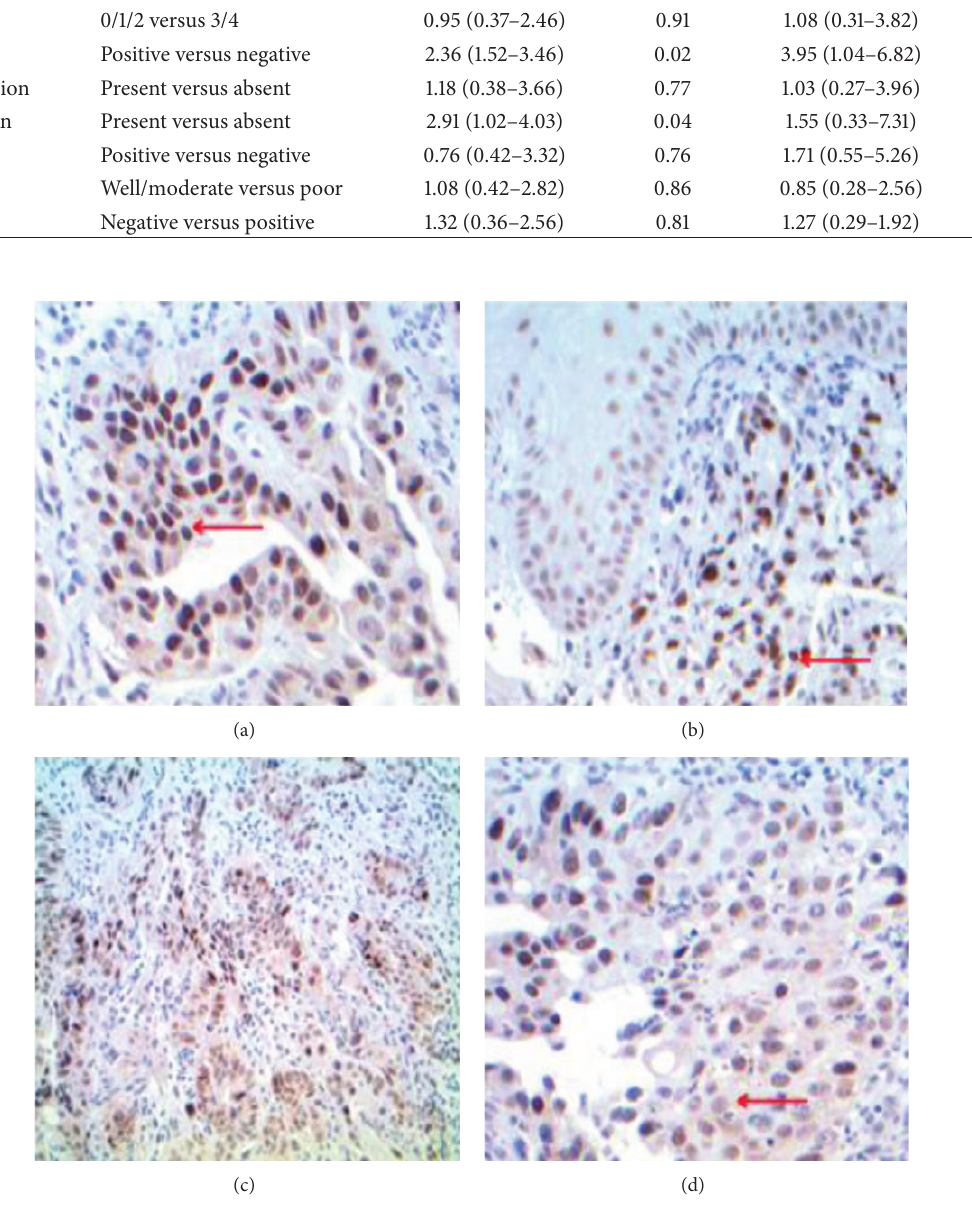
Figure 1: Immunohistochemical staining for TS expression. (a) Expression in the nucleus of tumour cells (red arrow × 200). (b) Expression in tumour and normal gastric cells × 40. (c) Moderate expression in tumour cells × 40. (d) Weak/moderate staining in the cytoplasm of tumour cells (red arrow ×